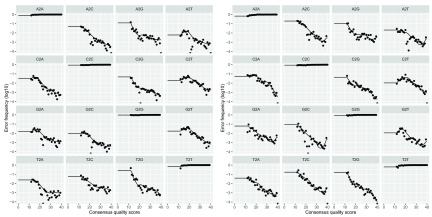
Forward and Reverse Read Error Profiles, showing the frequencies of each type of nucleotide transition as a function of quality.